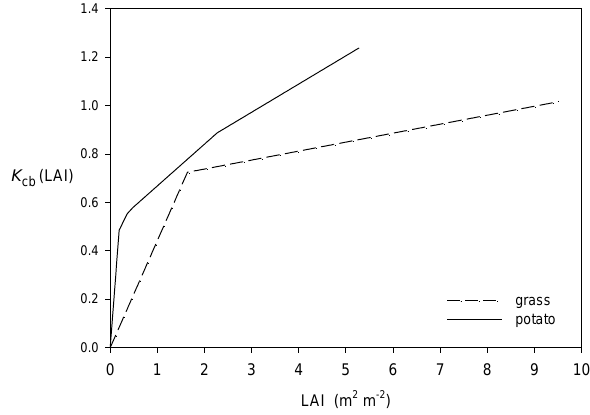
Fig. 4 Fig. 4. Fitted relationships between the leaf area index (LAI) and the crop factor K cb (of Makkink reference crop evapotranspiration), for potato and grassland. The shown relationships are for Eq. (1).